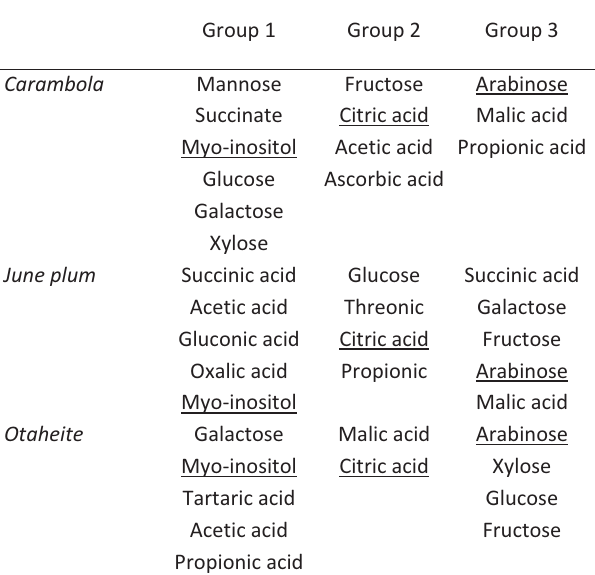
Table 3 ­ The hierarchical clusters distribution of the profiled metabolites of carambola, June plum and otaheite during the three stages (underlined metabolites are classified within the same groups of the three